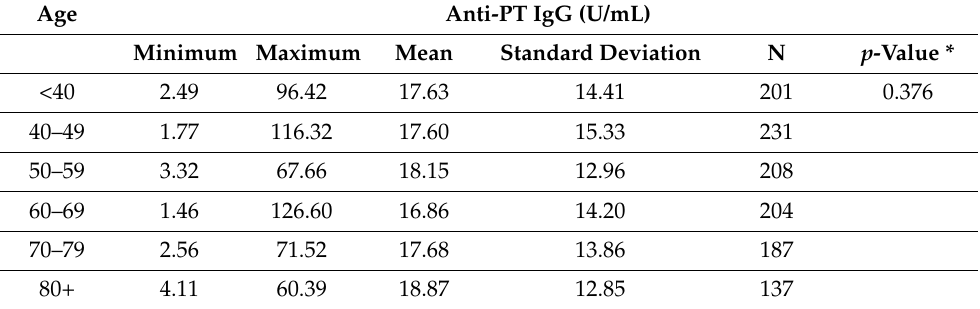
Table 3. Pertussis anti-PT IgG by age